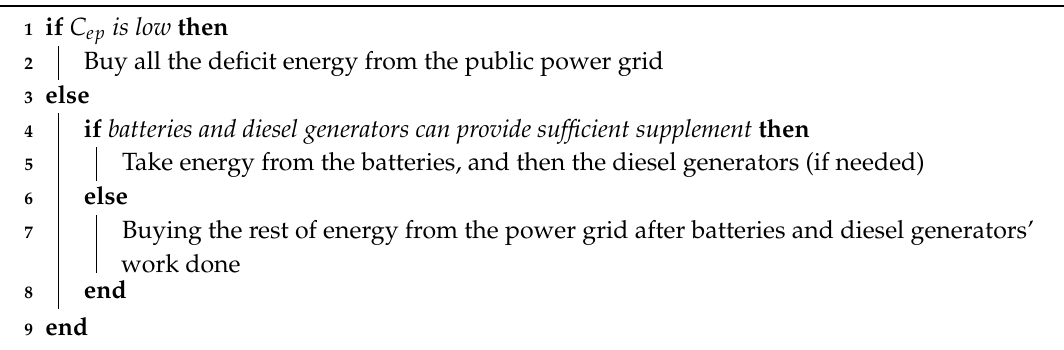
Algorithm 1: Decision strategy for the source of supplementing deficit energy in mode II.